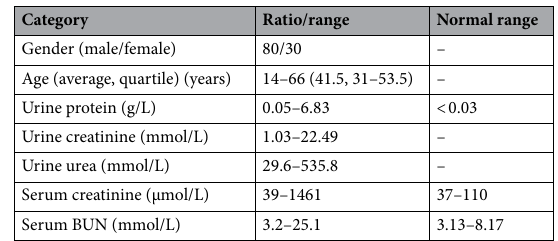
Table 1. Basic characteristics of kidney transplant